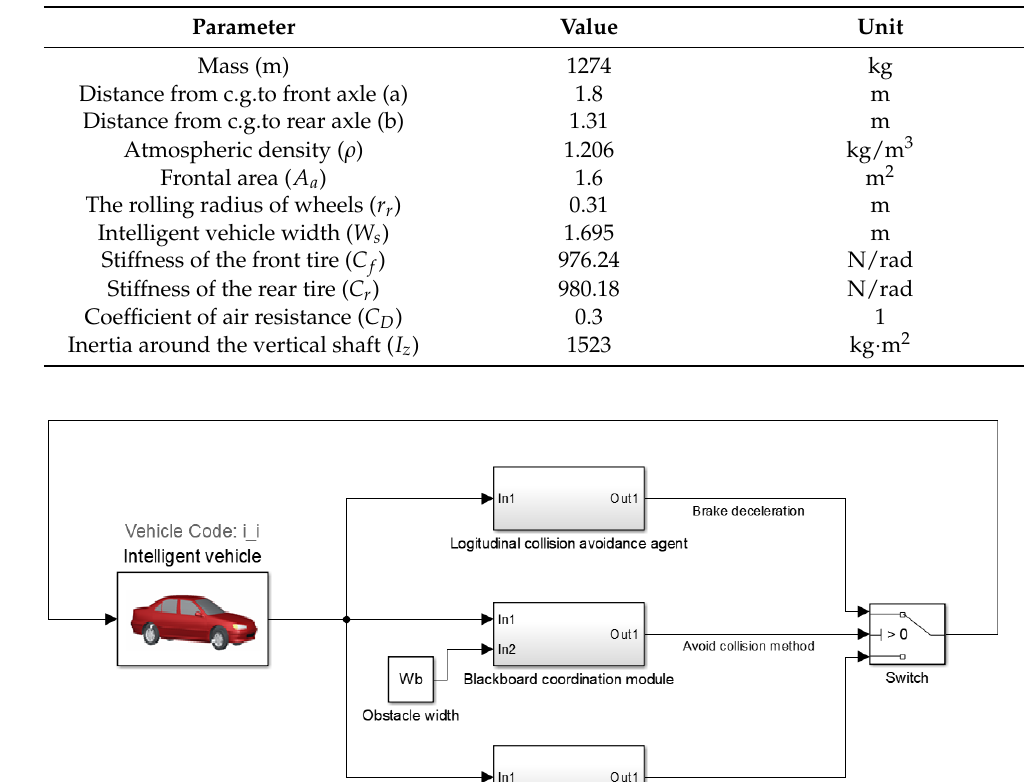
Table 1. Basic parameters of the vehicle. Parameter Value Unit Mass (m) 1274 kg Distance from c.g.to front axle (a) 1.8